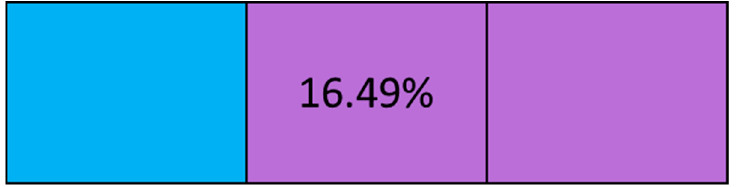
Figure 16. The optimum solution for the 3-mod problem (OI = 16.49%) according to the genetic algorithm with one membrane separator module (blue) and two membrane reactor modules (purple).